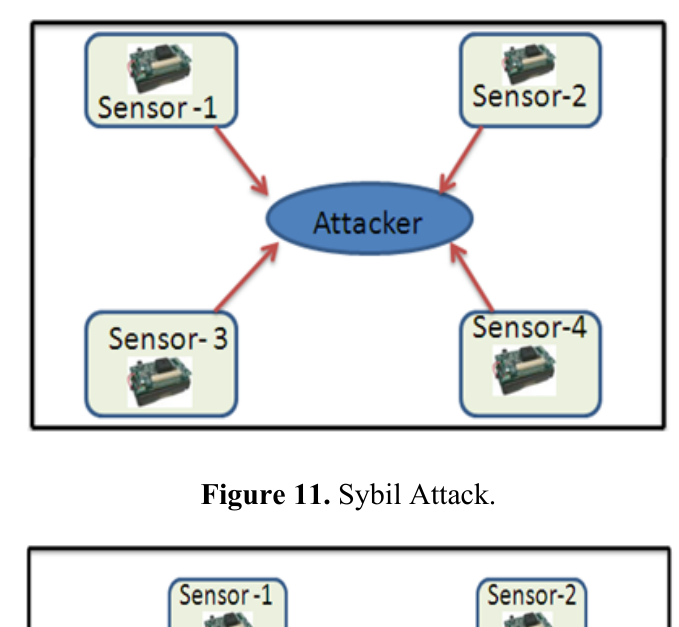
Figure 10. Sinkhole Attack.